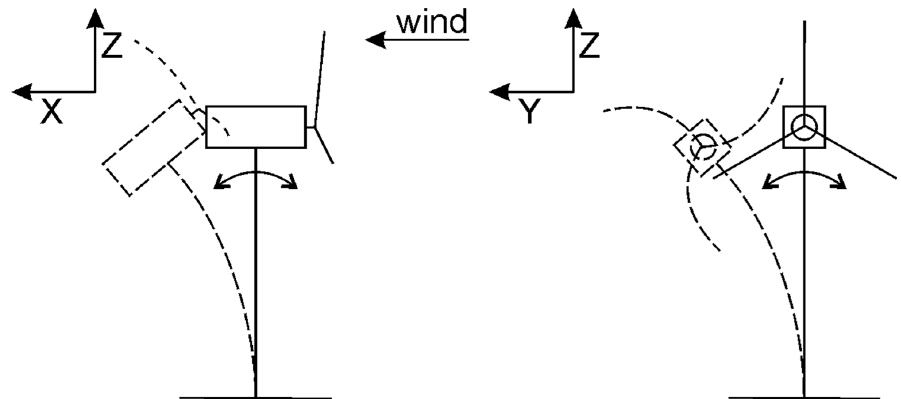
Figure 2. DoF of a